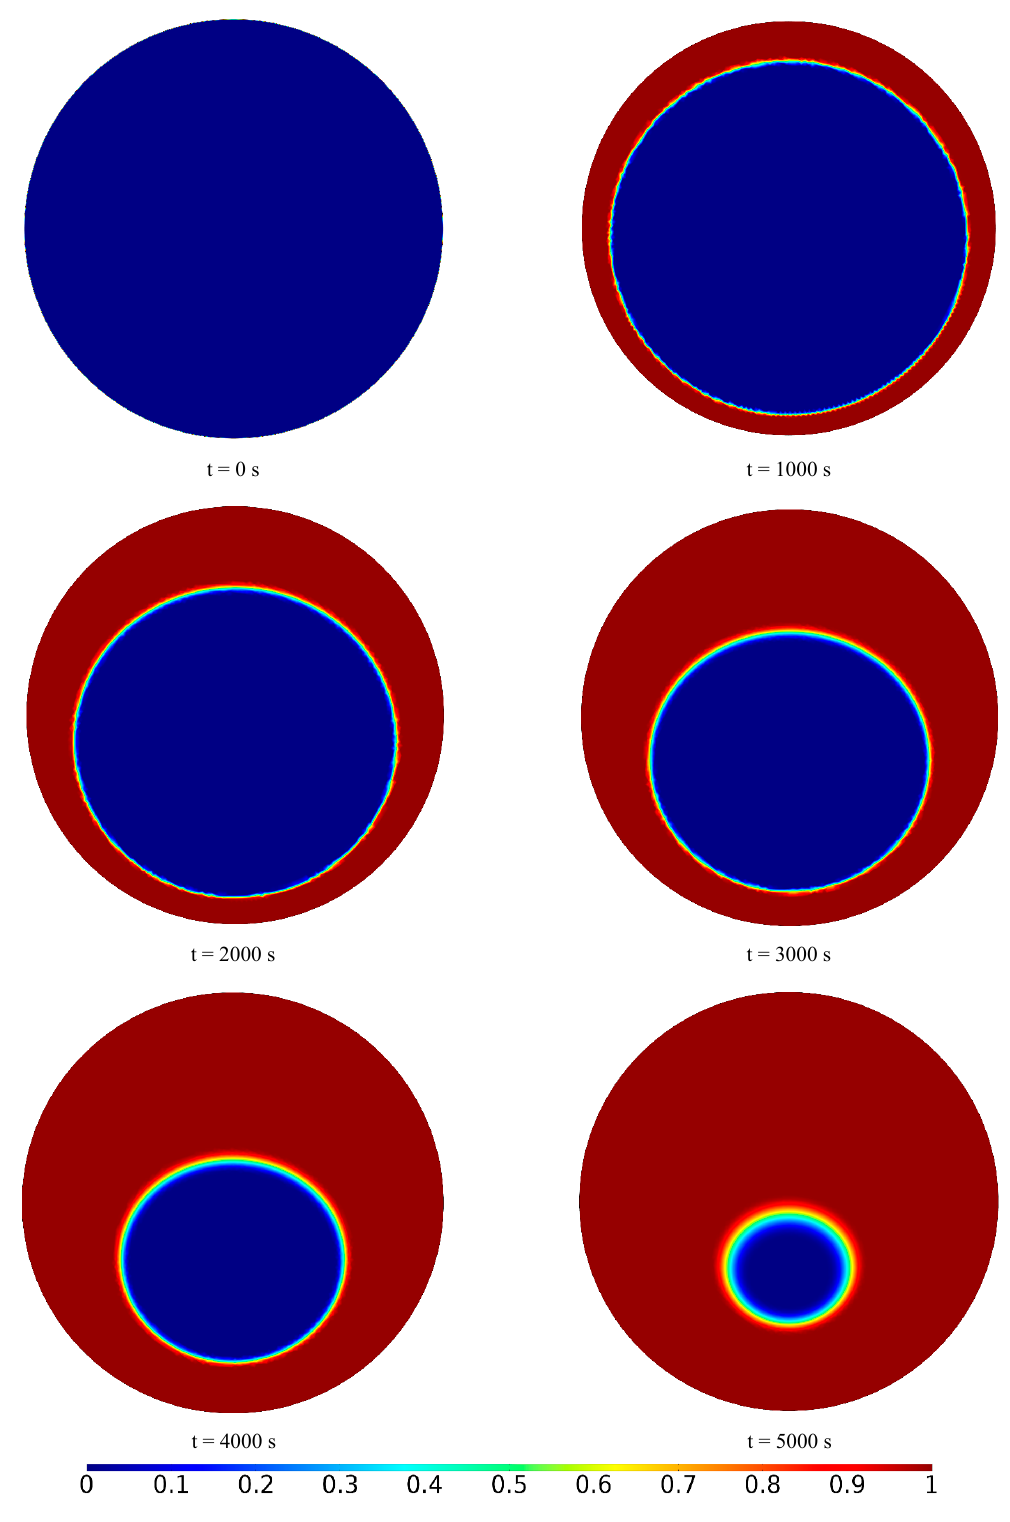
Figure 4. PCM melting contours in a tube filled with PCM from 0 to 5000 s with a time interval of 1000 s.